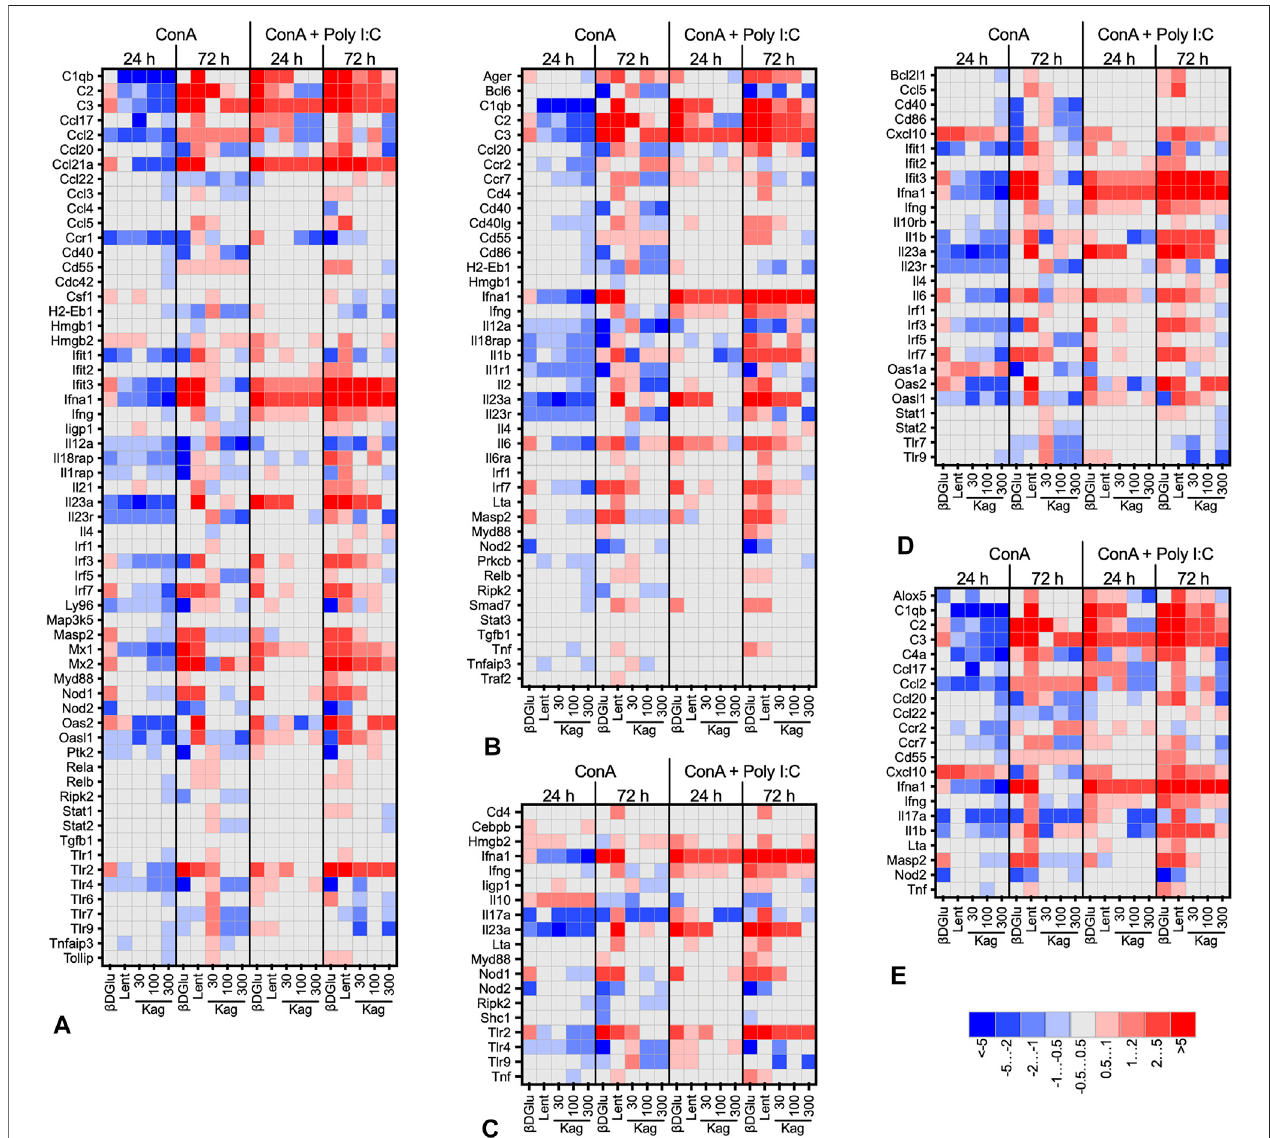
FIGURE 3 | Heat map (log 2 -fold change of expression) of genes involved in innate immune response, GO:0045087 (A) , adaptive immune response, GO: 0002250 (B) , defense response tobacteria, GO:0042742 (C) , defense response tovirus, GO:0051607 (D) , and humoralimmuneresponse, GO:0019730 (E) in murine Peyer ’ s patches lymphocytes stimulated with concanavalin A (ConA) in absence or presence of TLR-3 ligand poly I:C after 24 and 72 h after treatment with 300 μ g/ml oats β -DGlucan,300 μ g/mllentinanor30-300 μ g/mlkagocel(Kag)ascomparedtocontrol,saline-treated,lymphocytes.RNAwascollectedin3independentruns of the